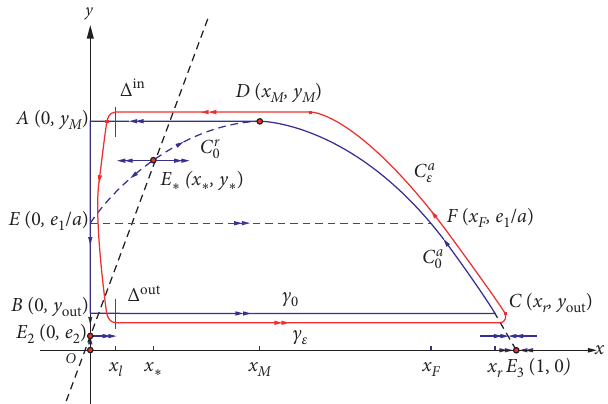
Figure 2: Illustration for the relaxation oscillations of system (9). The critical manifold C contains repelling part C r and attracting 0 0 . The dashed black line is the predator isocline, the red dot is part C a 0 the fold point D ( x M , y M ) , the solid blue line is the slow-fast cycle c , the double and single arrows are fast and slow flows, and the 0 solid red is the attracting relaxation oscillation c ε